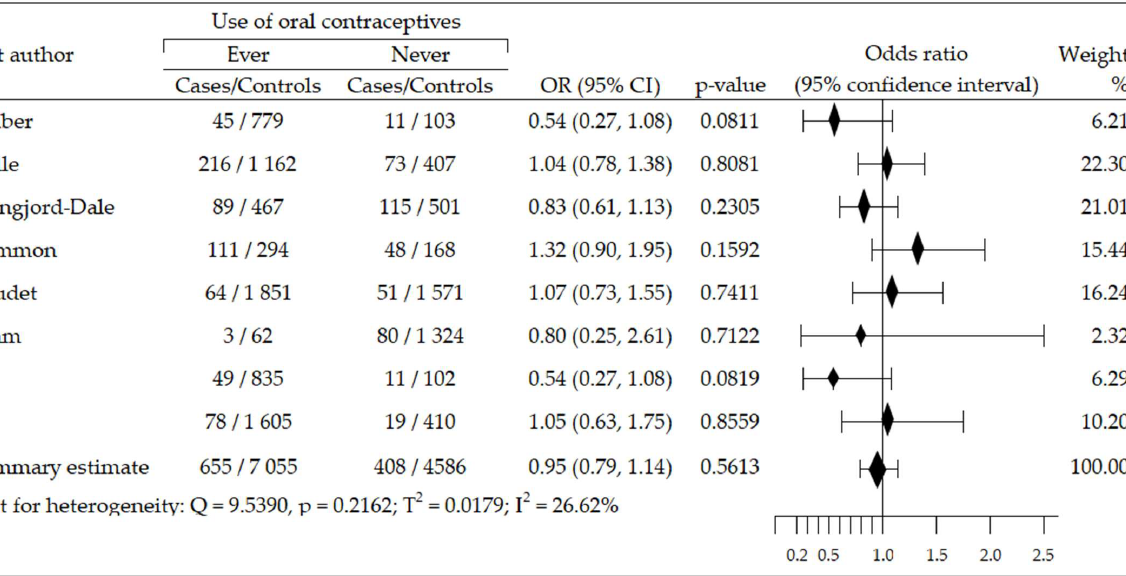
Figure 4. Forest plot and summary odds ratios on the association between risk of HER2+BrCa and ever-use of oral contraceptives. Note: black diamonds represent the effect sizes; the horizontal lines denote the 95% confidence interval.